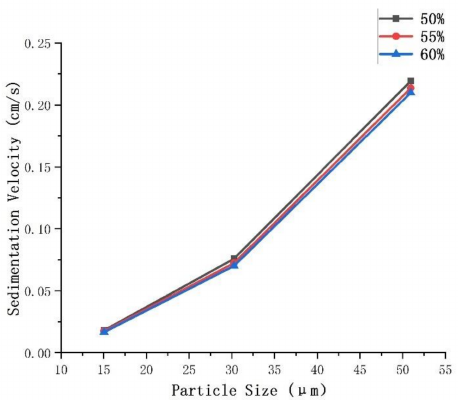
Figure 8. Relationship between the particle size and sedimentation